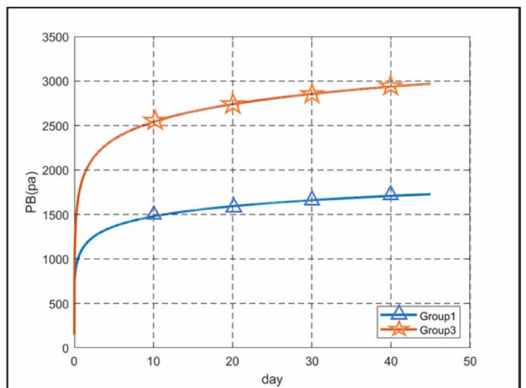
Figure 4. The results of Group1 and Group3 simulation on the pressure drop for 45 days.